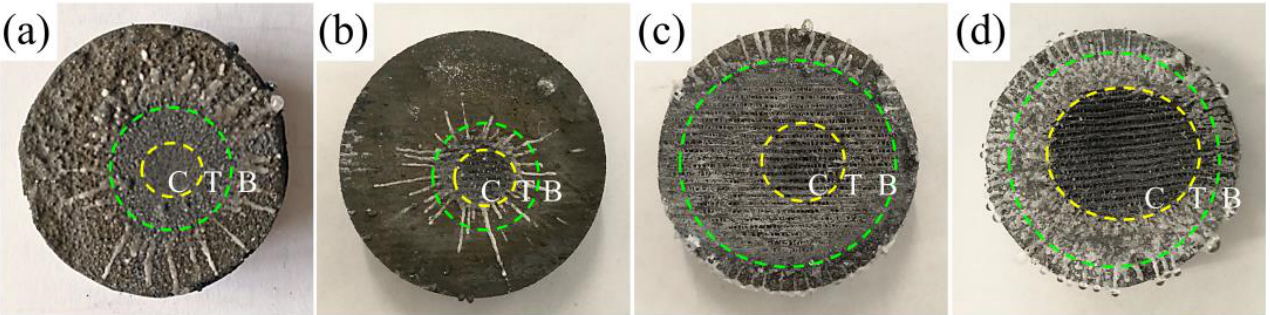
Figure 7. Photographs of the AlSiB-C/C composites after ablating for ( a ) 25 s, ( b ) 50 s, ( c ) 100 s and ( d ) 150 s (C, center region; T, transition region; B, brim region).